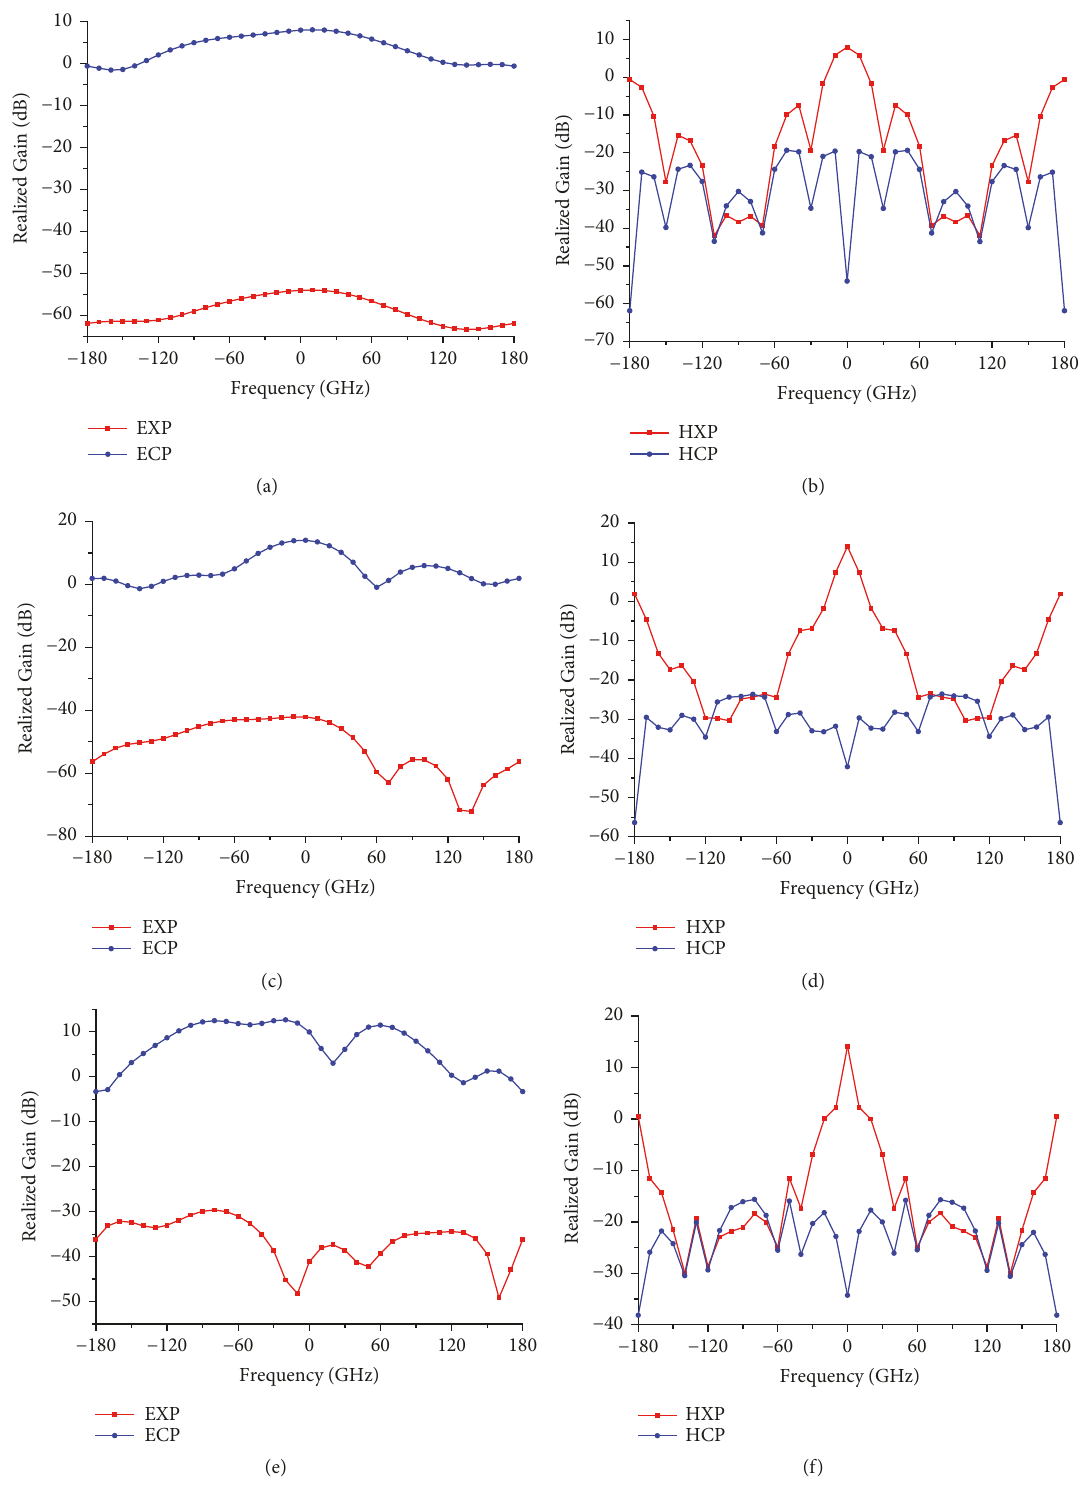
Figure 13: Primary polarization and cross polarization of the DRA array. (a) E-plane at 7GHz. (b) H-plane at 7 GHz. (c) E-plane at 12GHz. (d) H-plane at 12GHz. (e) E-plane at 15 GHz. (f) H-plane at